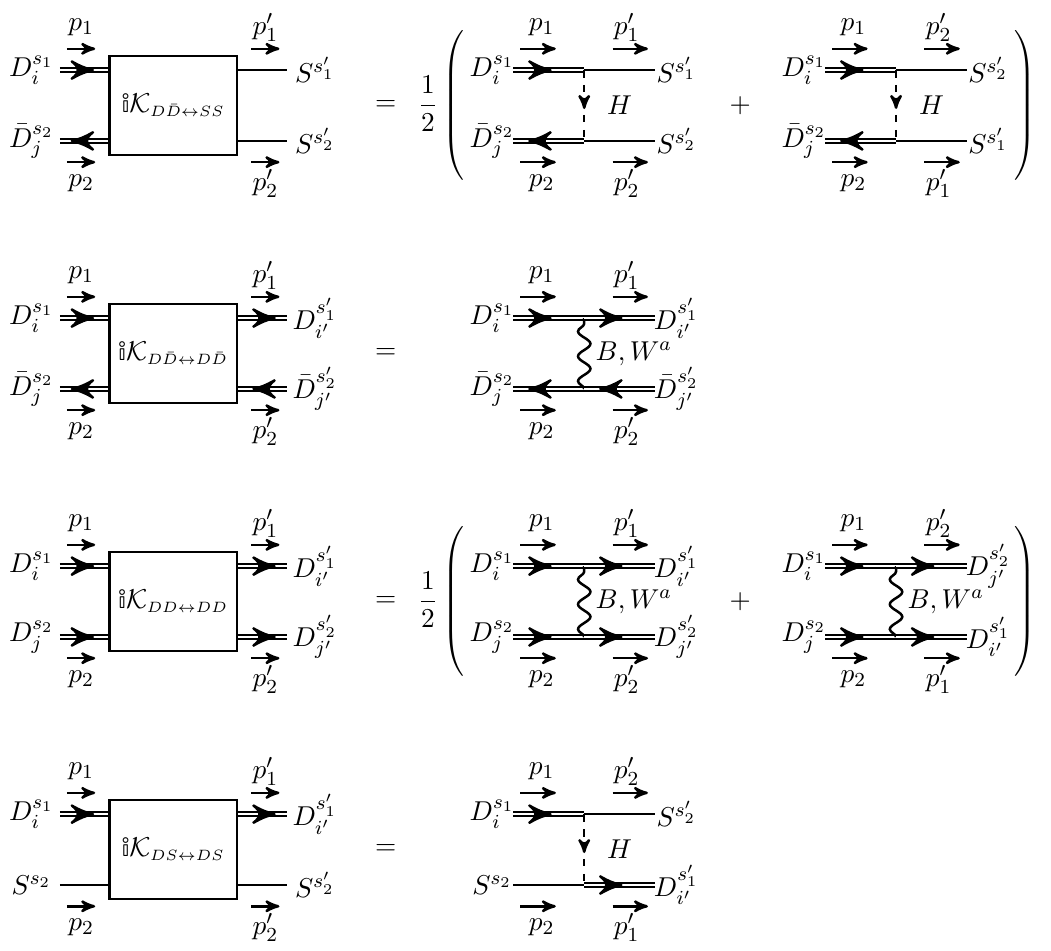
¯ D and S fermions.